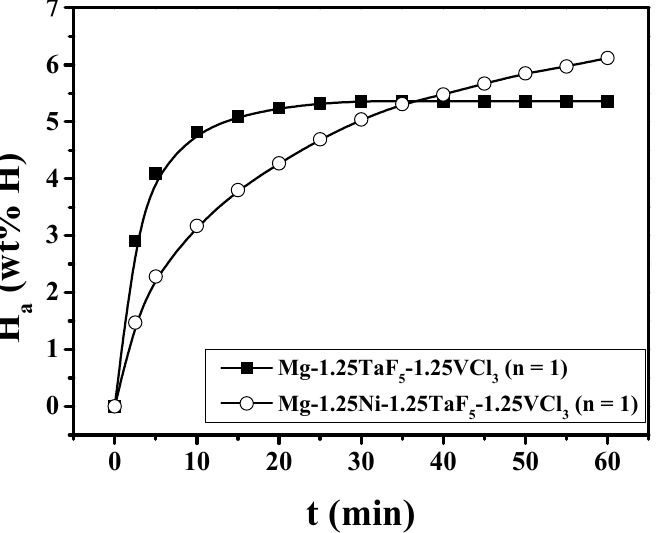
Figure 1. H a vs. t curves at 593 K under 12 bar H 2 at n = 1 for Mg-1.25TaF 5 -1.25VCl 3 and Mg-1.25Ni-1.25TaF 5 -1.25VCl 3 .